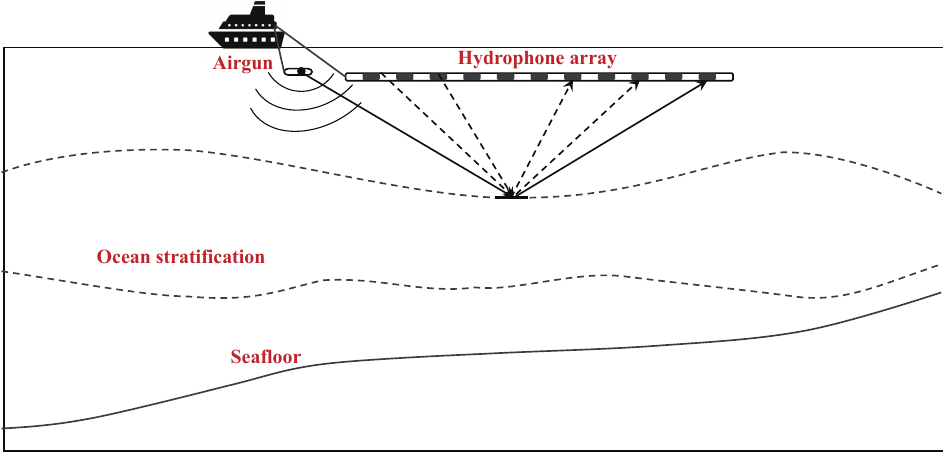
Figure 7. Demonstration of seismic data